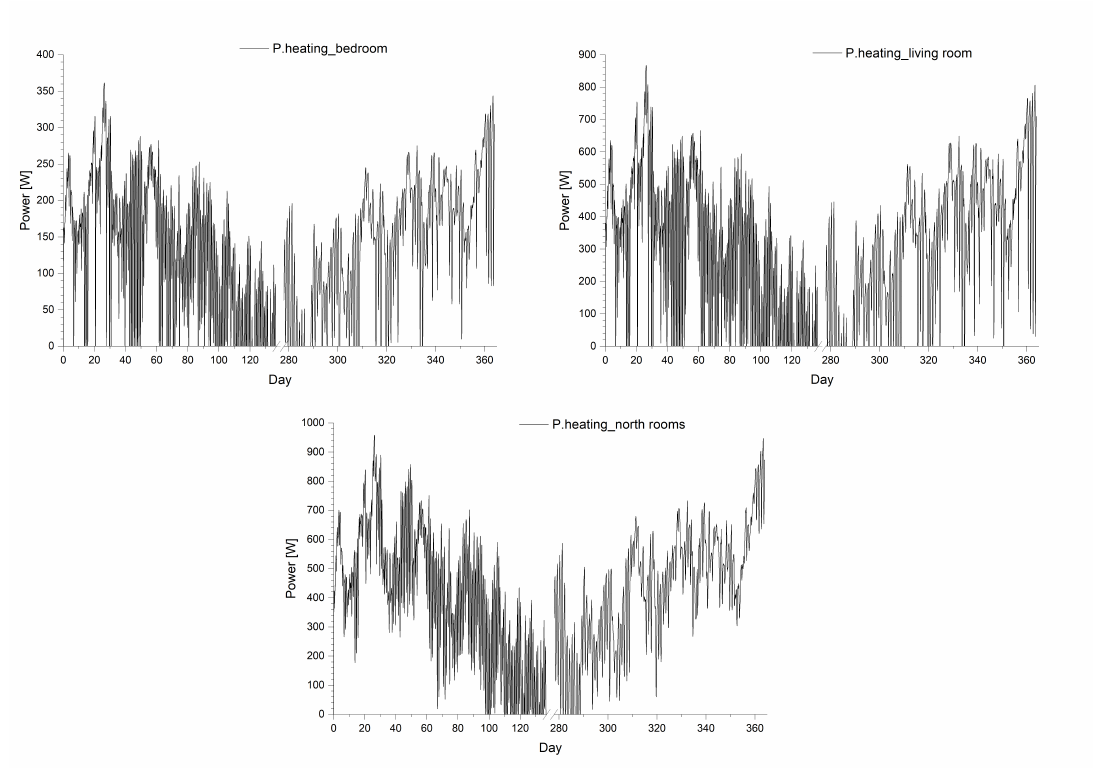
Figure 7. Variations in heating power inside the bedroom, living room and north-facing rooms for the thermal simulation of the reference case.